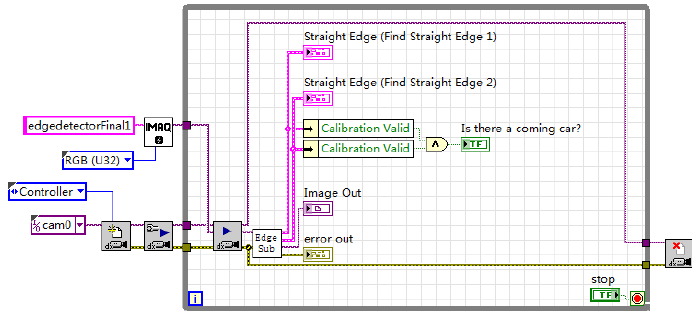
Figure 4. Program block diagram of vehicle target recognition.